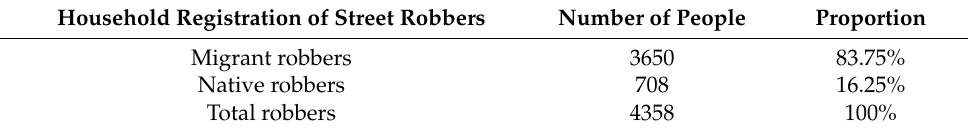
Table 2. Descriptive statistical analysis of household registration attributes of street